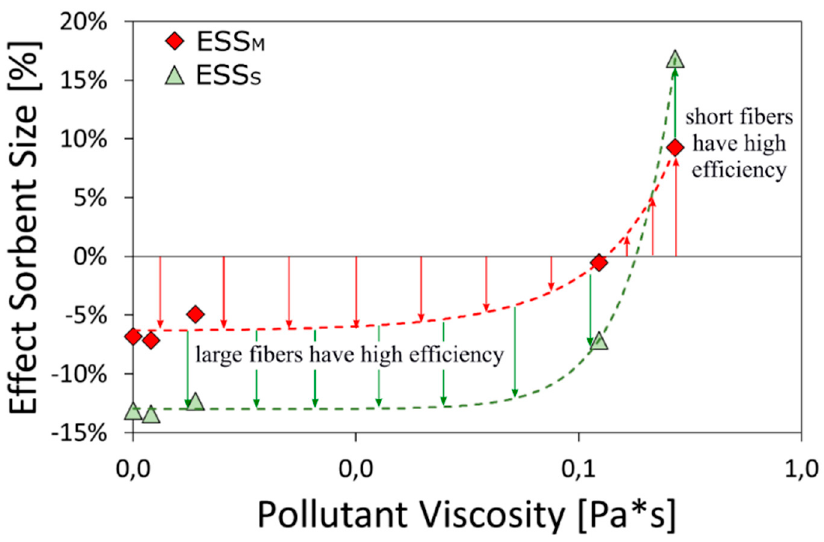
Figure 6. Evolution of the e ff ect sorbent size index at varying pollutant viscosity.